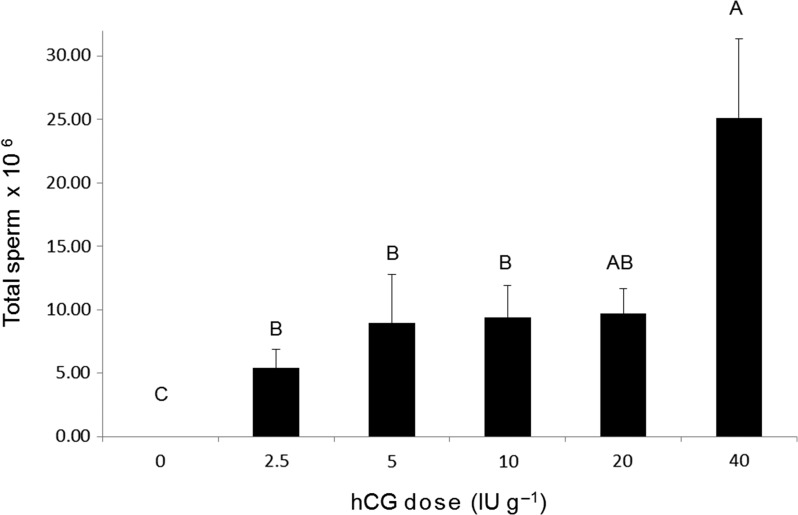
Effect of hCG dose on the total number of sperm released. Data are shown as the mean ± SEM (n = 8–10 per treatment). Letters displayed are the result of Wilcoxin post hoc tests. Treatments that share a letter are not significantly different (P > 0.05).